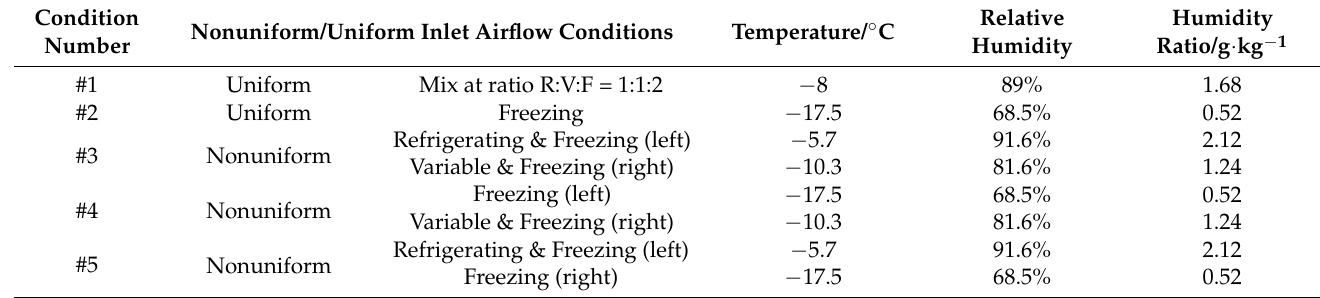
Table 5. Different temperature and humidity conditions of frontal air flow